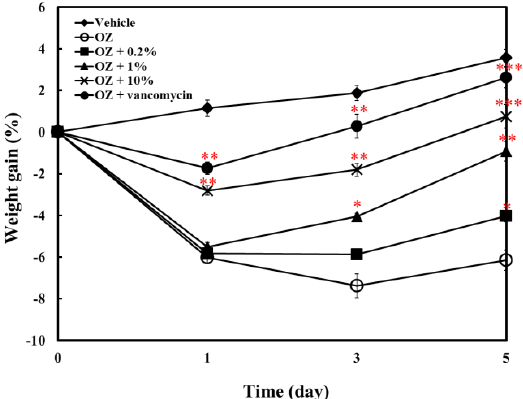
Figure 7. Effect of ACEW supplement on weight gain of zebrafish in therapeutic mode experiment of oxazolone-induced acute enteritis. Zebrafish were fed with different experimental diets after induction, and were weighted at day 1, 3, and 5. Significant difference of gene expression between the ACEW supplemented diet and the control diet group (group OZ without ACEW addition) was denoted as * p < 0.05, ** p < 0.01, and *** p <